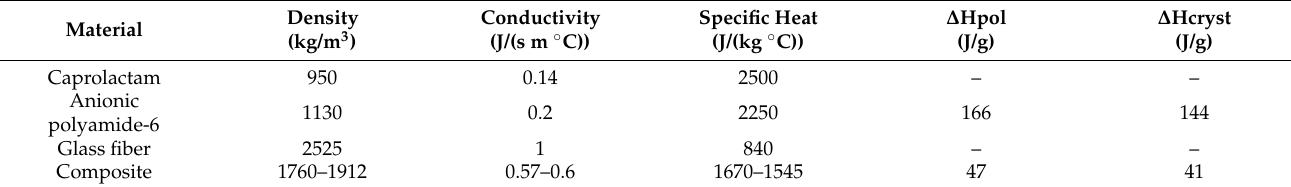
Table 3. Thermal properties. Reproduced from Reference [44].